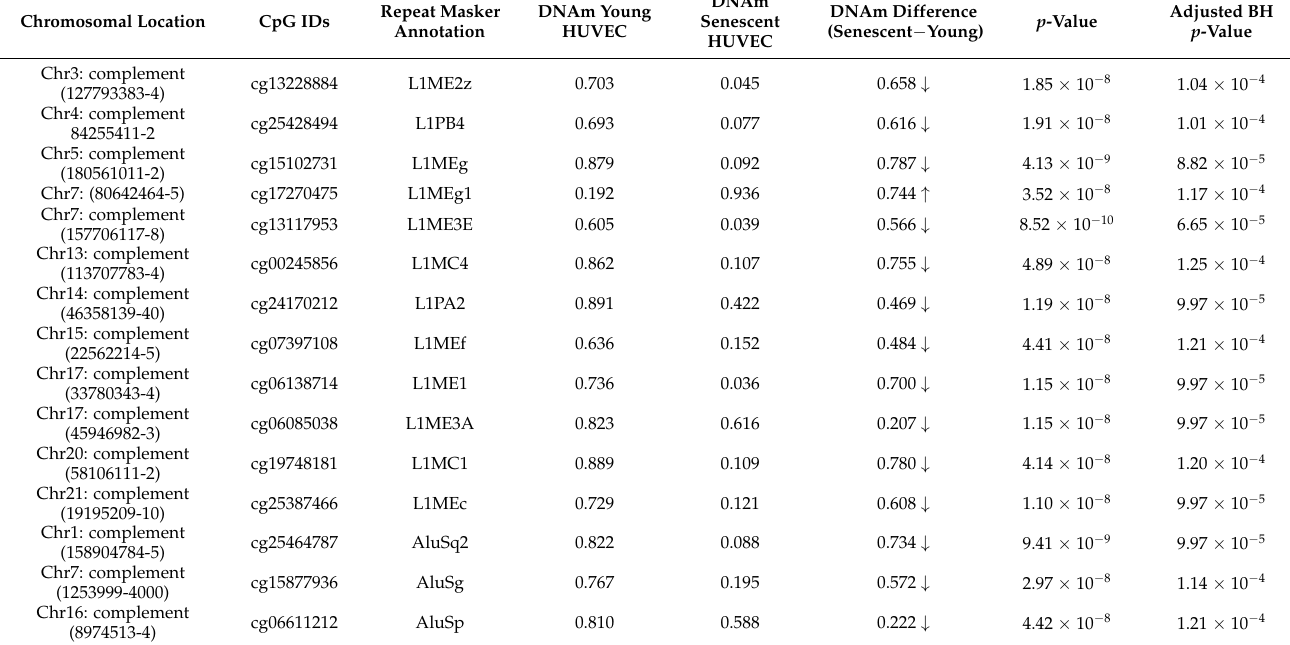
Table 1. Methylation differences of TEs between senescent and young HUVECs. Methylation of CpG sites is expressed as DNAm score, ranging from 0 to 1. ↑ indicates hypermethylation of the specific CpG in senescent HUVECs compared to young HUVECs. ↓ indicates demethylation of the specific CpG probe in senescent HUVECs compared to young